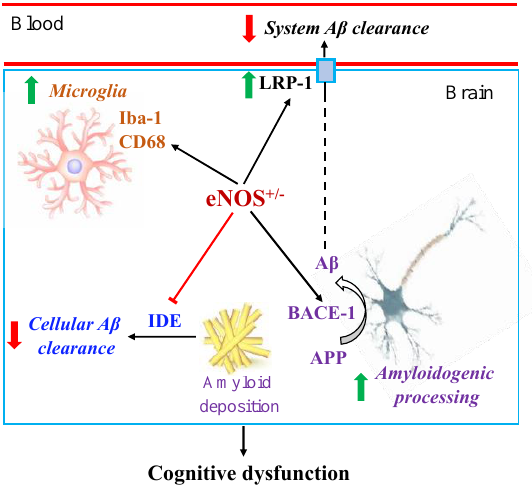
Figure 8. Schematic diagram illustrating how partial eNOS deficiency (eNOS +/ − ) aggravates cognitive dysfunction in APP/PS1 mice. The findings of the present study suggest that partial eNOS deficiency leads to augmented amyloidogenic processing of amyloid precursor protein (APP; hence increased amyloid beta ( Aβ ) production) , reduced Aβ clearance and augmented microglial pathology in APP/PS1 mice, as evidenced by the upregulation of beta-site amyloid precursor protein cleaving enzyme-1 (BACE-1) and low density lipoprotein receptor-related protein-1 (LRP-1; speculatively a compensatory response), increased immunoreactivity of ionized calcium-binding adapter molecule 1 (Iba-1) and cluster of differentiation 68 (CD68), and the downregulation of insulin-degrading enzyme (IDE). These changes ultimately aggravate cognitive dysfunction in APP/PS1 mice.